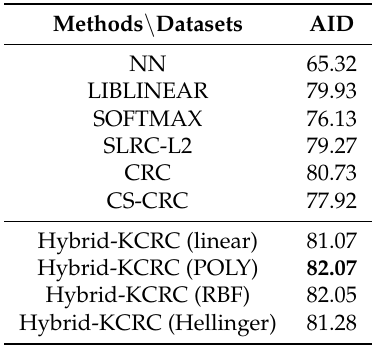
Table 5. Comparison with several classical classification methods on the AID dataset